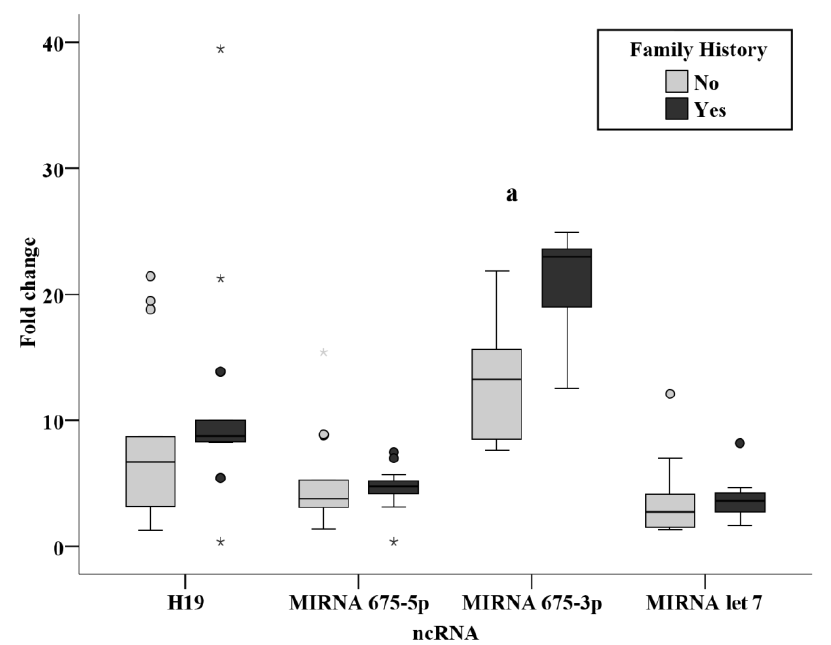
Figure 10. Relation between ncRNAs and family history in presurgery BC patients. *—Extreme value: a — Significant between ncRNA and FH using Mann Whitney test.